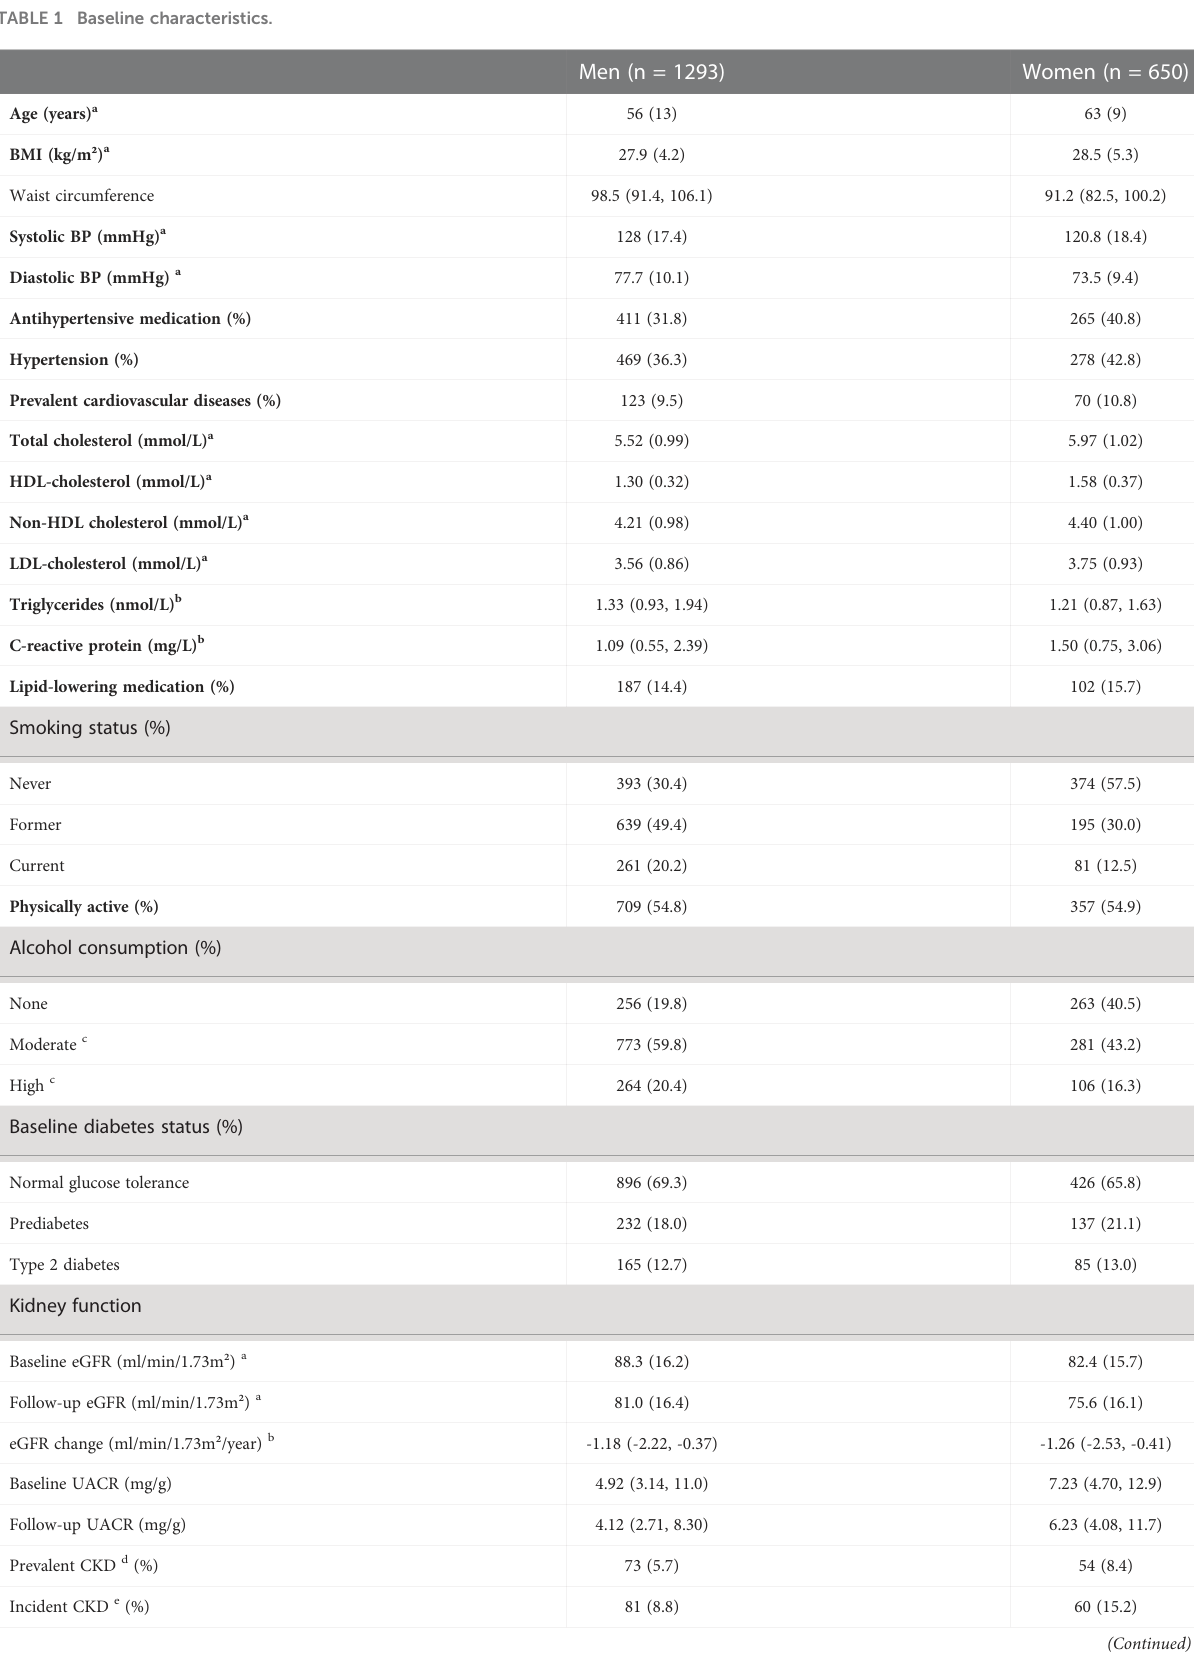
TABLE 1 Baseline